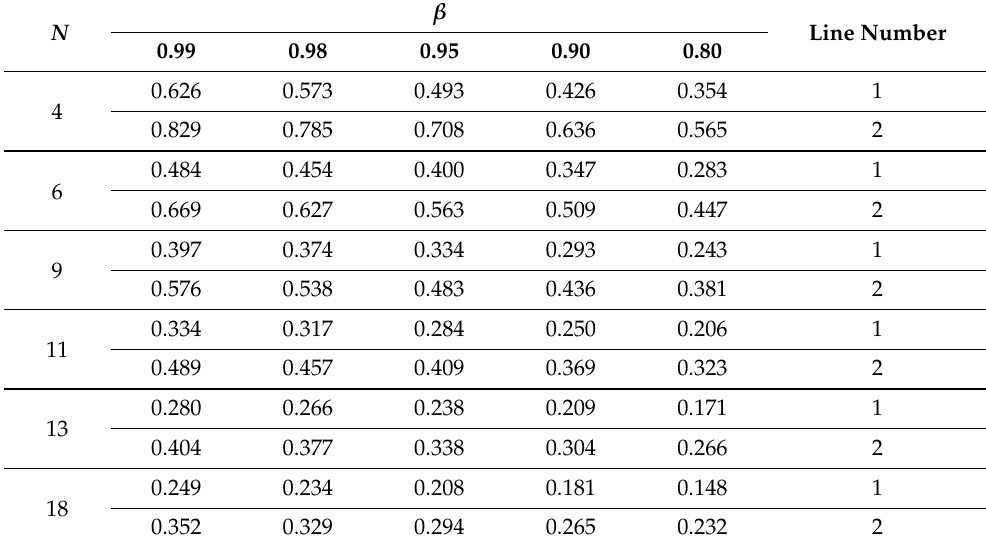
Table 9. Statistics values DN M ( β )